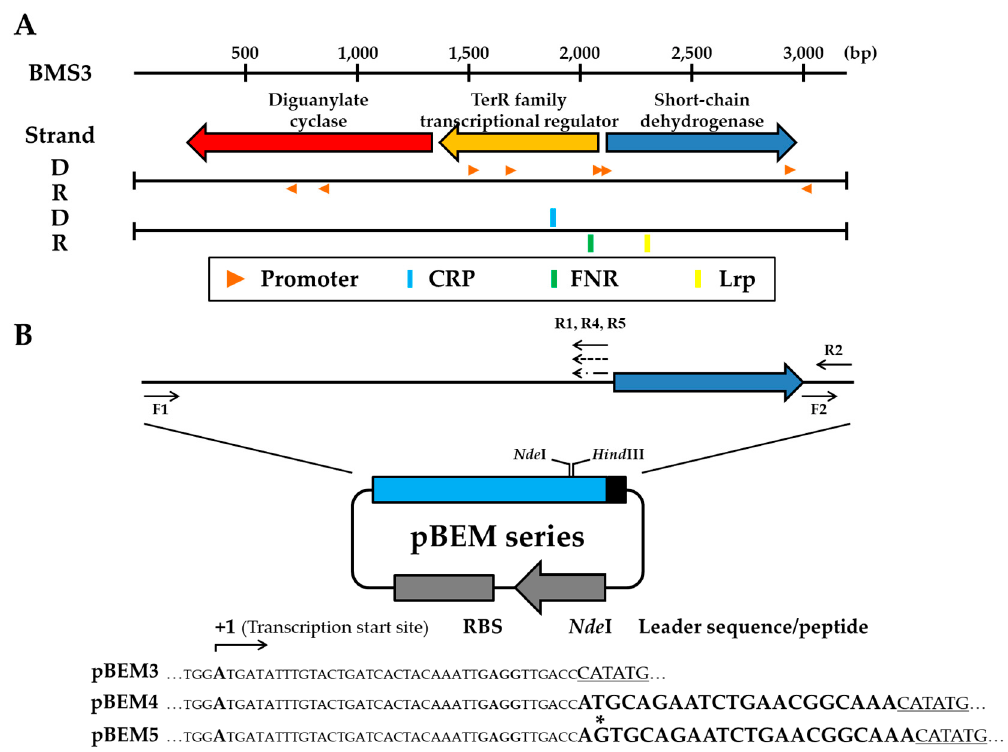
Figure 2. Analyses of structural organization of the BMS3 DNA sequence and construction of pBEM series expression vectors. ( A ) Deduced ORFs in BMS3 DNA. The innate overexpressed ORF in BMS3 DNA was identified as a gene encoding a short-chain dehydrogenase mBFP. The promoters and binding regions for regulatory proteins predicted by using methods described in Materials and Methods were also shown in the BMS3 DNA. ( B ) A physical map of the new expression system (pBEM series vector). pBEM3 vector was constructed using BMS3 DNA without the mbfp (short-chain dehydrogenase) gene. pBEM4 and pBEM5 included an arbitrary leader sequence or peptide of the 5 ′ sequence of the gene encoding mBFP. All vectors have the same transcription start site and RBS (GAGG). However, due to the changing of ATG to AGTG in the leader sequence of pBEM5, these two expression vectors have different translation initiation regions. The blue and black box indicates BMS3 DNA without the mbfp and transcription terminator, respectively. The gray box indicates the antibiotic selection marker with its own promoter (arrowed).